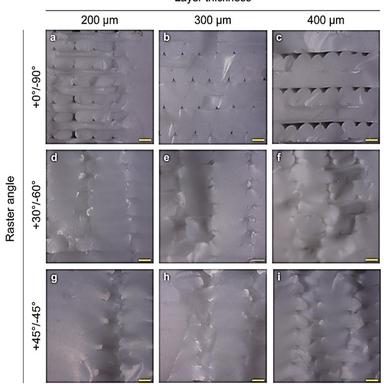
Microscope images of cross-sectional morphology of fractured sintered bending zirconia specimens (scale bar: 500 µm).